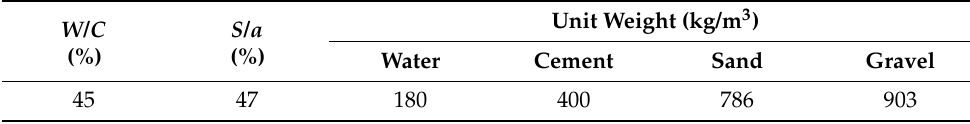
Table 3. Mixing proportion of sewage concrete.